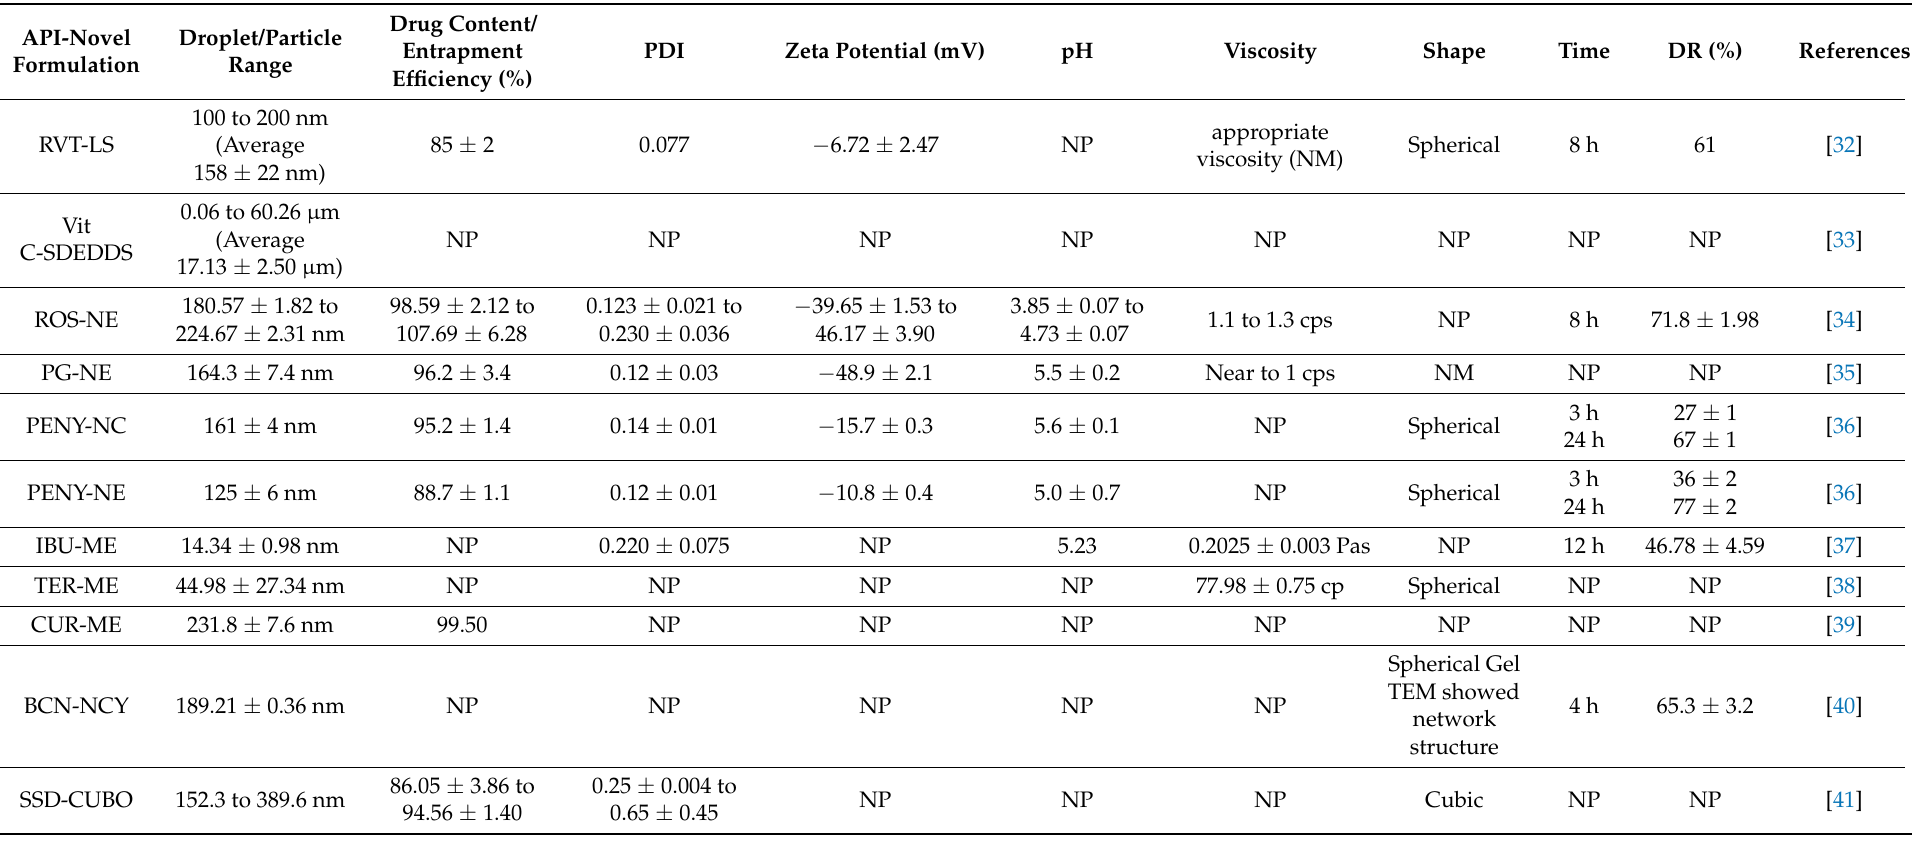
Table 2. Different novel formulation evaluation studies before incorporating into